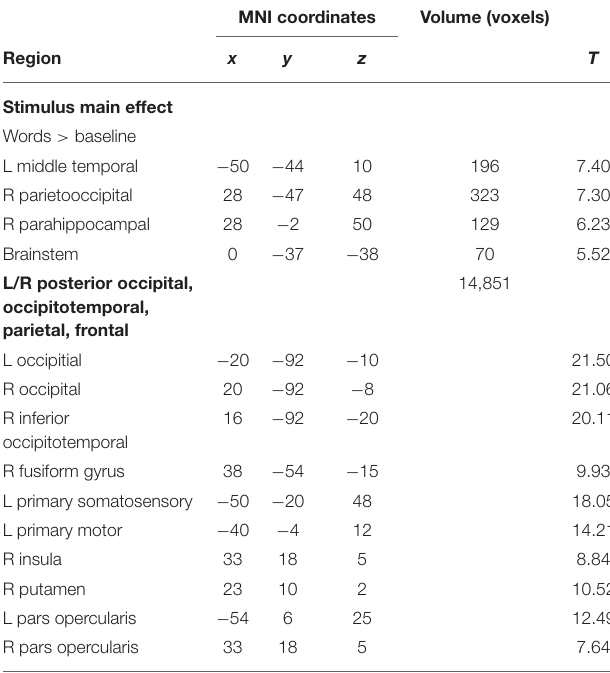
TABLE 3 | Significant cluster of the whole brain